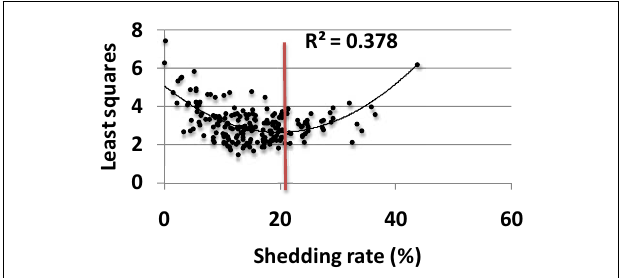
FIGURE 4 | Model parameters are optimized for high shedding . Results from 200, 10-year model simulations, each with randomly selected parameter values. Simulations with best fit to all features of shedding episode features (rate, duration, early expansion and late decay kinetics, peak viral production and, expansion and decay slopes) lead to lowest least squares values ( y -axis) and also most closely approximate the population levels shedding rate of 18% (red line); only 40 of 200 parameter sets lead to shedding rate > 18%, implying that viral and immunologic parameters are relatively well calibrated to allow maximal shedding. Black line is a Lowess smoothed curve.